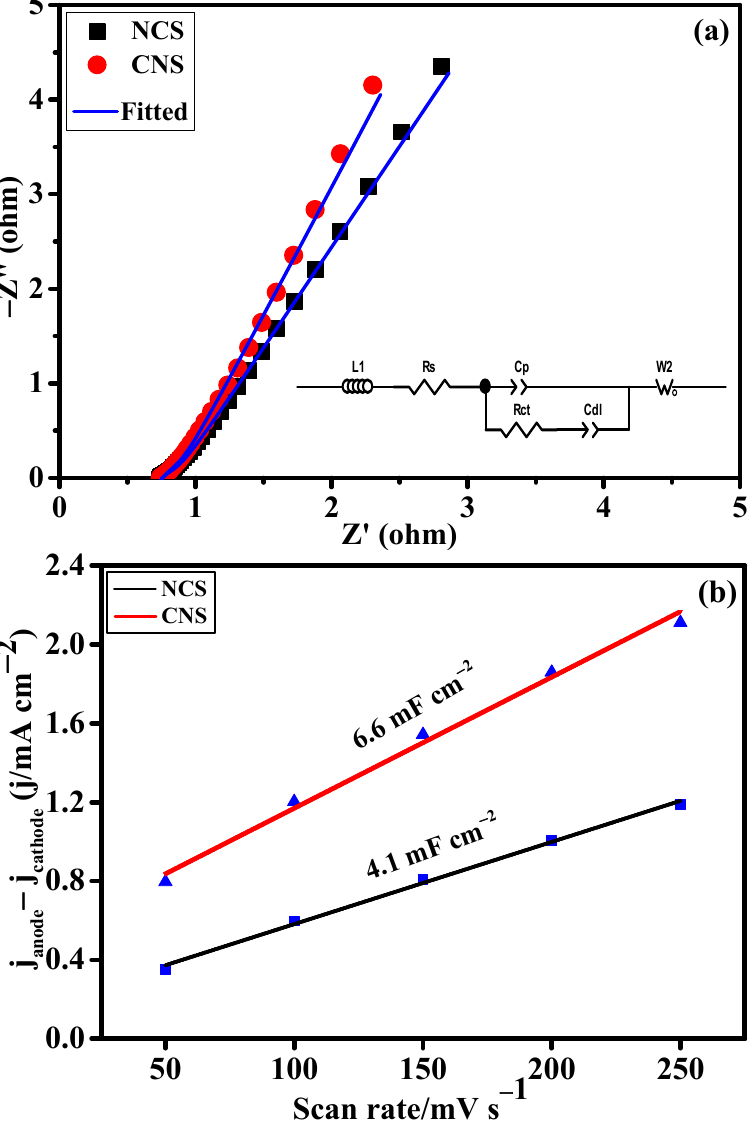
Figure 5. The intrinsic electrochemical properties of the as-prepared NCS and CNS electrodes. ( a ) Nyquist plots and the inset is equivalent circuit model and ( b ) plots of the current density differences vs. the scan